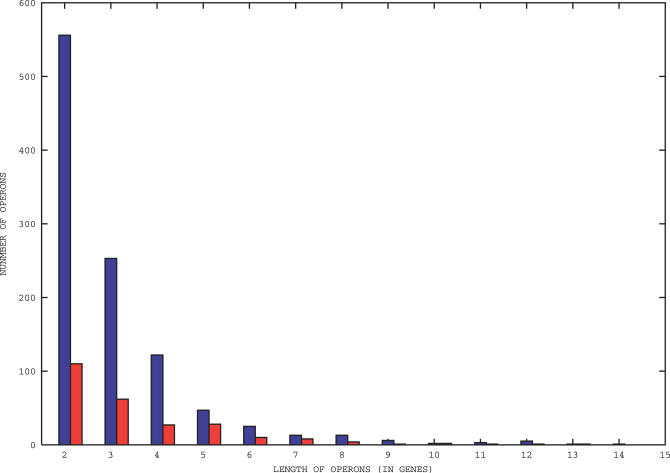
The Histograms of Lengths of the Known Operons for B. subtilis and E. coli K12Blue boxes are for B. subtilis, and red boxes are for E. coli K12.